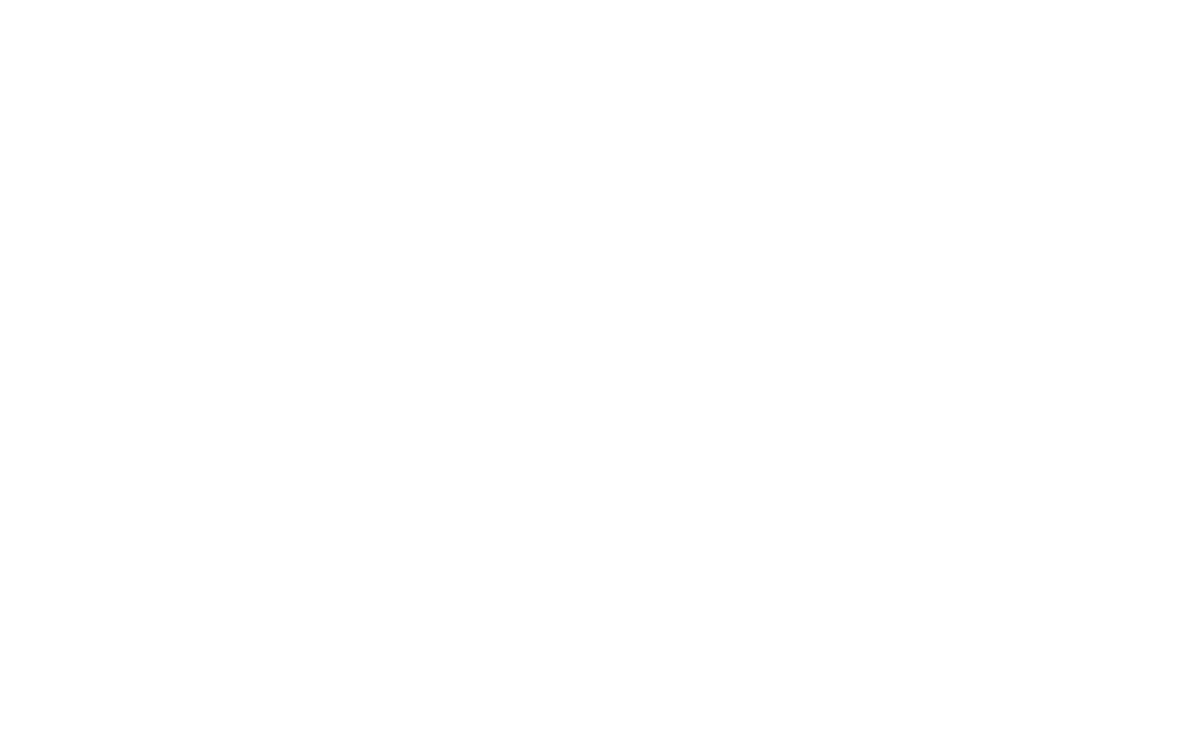
- Endurance: 1.5 h normal cruise flight. High altitude 40 min. start and